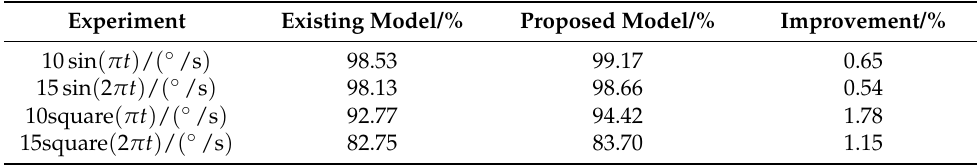
Table 4. The Pearson correlation coefficient for closed-loop time